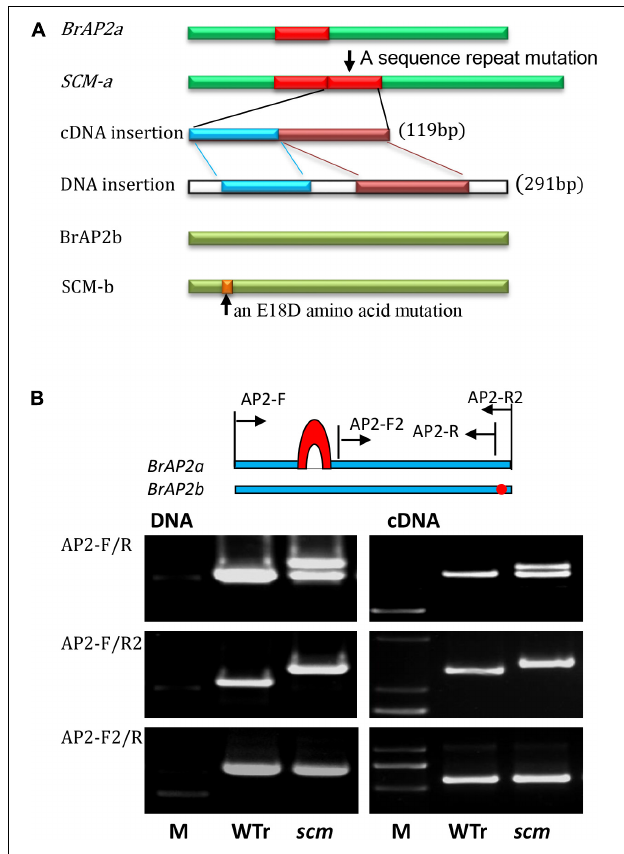
FIGURE 3 | Mutations of the two AP2 orthologs in the scm of B. rapa. (A) Schematic of the two AP2 gene mutations in scm . The BrAP2a cDNA from scm ( SCM-a ) had a 119-bp sequence repeat mutation, which was derived from the transcription of a 291-bp repeat in genomic DNA that consisted of nucleotides 648–938 repeated after nucleotide 938. BrAP2b cDNA of scm ( SCM-b ) had an A to C single nucleotide mutation that transformed the 18th glutamic acid into aspartic acid (E18D). (B) A schematic of the location of the designed primers. The relative locations of the AP2 primers in the scm and wild-type B. rapa (WTr) sequences are shown (upper part). PCR amplification of genome DNA and cDNA of WTr and the scm using primer pairs of AP2-F/R, AP2-F/R2, and AP2-F2/R (lower